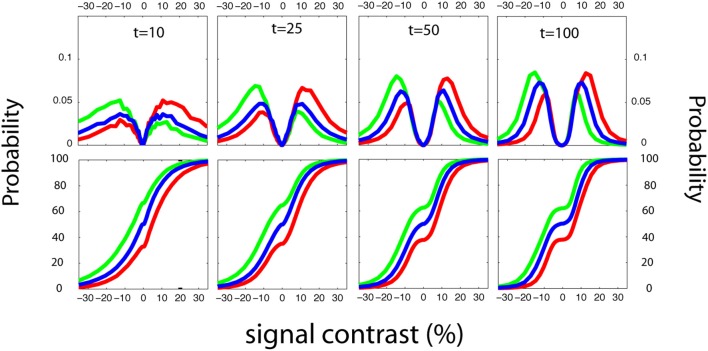
Stimulus sampling patterns for forced-choice detection. The quick FC's sampling is demonstrated by ordinary and cumulative stimulus histograms. The qFC method demonstrates a pattern similar those demonstrated by the YN adaptive methods; namely, that the stimulus sampling pattern matches the empirical psychometric function. For example, fewer stimuli are presented in the second interval to an observer who is biased against the second interval (Figure 5). This asymmetry is evident as early as the 10th trial.